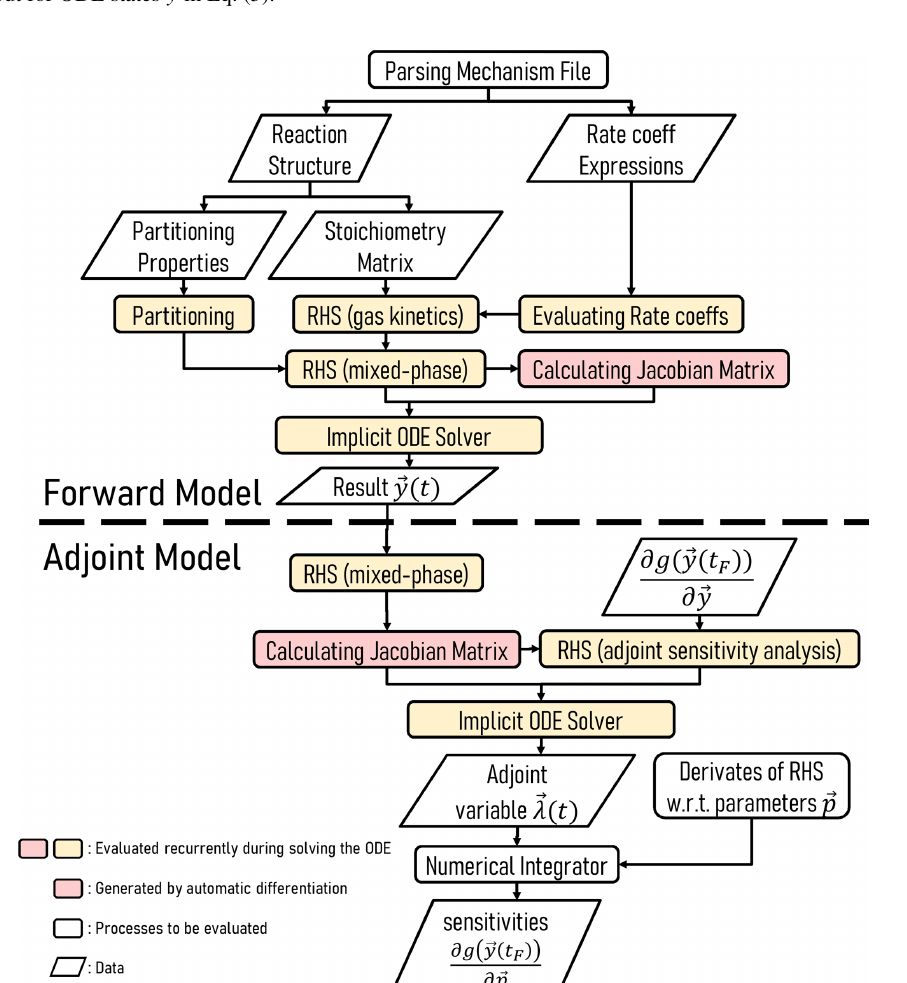
Figure 2. Schematic illustrating the structure of JlBox v1.1, whether in forward or adjoint